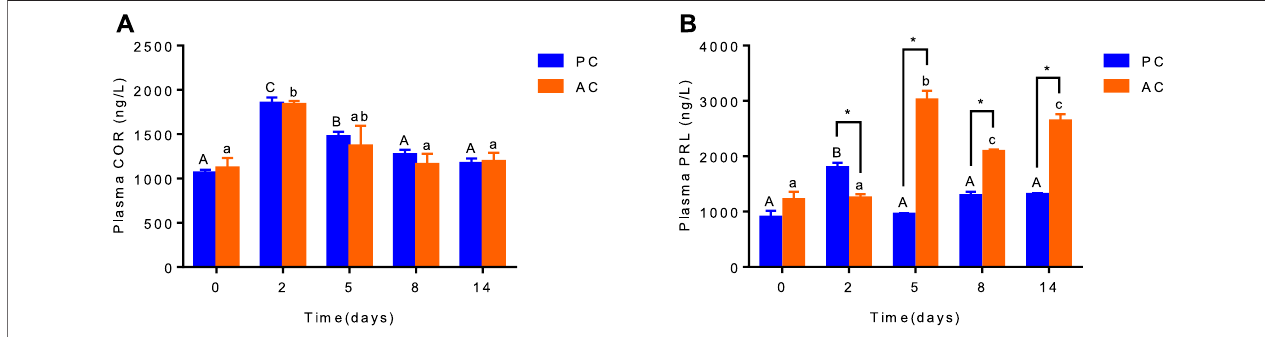
FIGURE 1 | The plasma cortisol (A) and prolactin (B) level in olive fl ounder with passive coping style (PC) and active coping style (AC) after transfer to fresh water. Data are mean ± SEM ( n = 3). An asterisk signi fi es a signi fi cant difference between the PC and AC groups at each time point ( p < 0.05). Different letters denote a signi fi cant difference across time within the same coping style group ( p < 0.05).